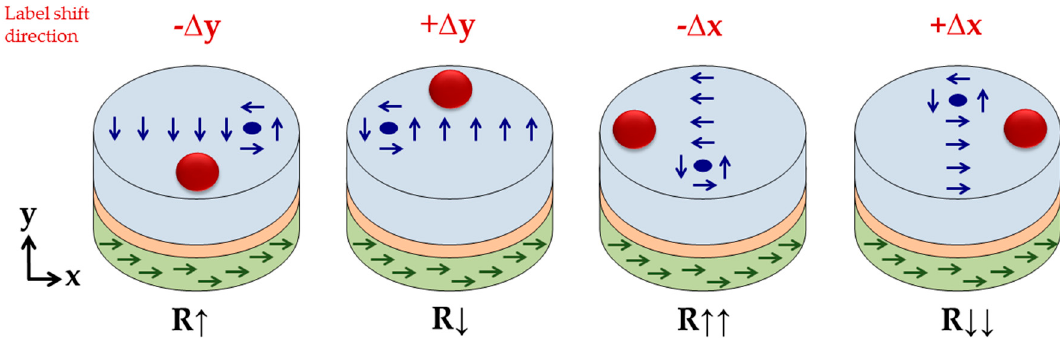
Figure 5. Sketch of the orthogonal movement of the magnetic vortex core with respect to the shift in the label. The shift in the magnetic vortex core leads to resistance changes across the GMR sensor stack, reaching its maximum resistance for label shifts in the x-direction.